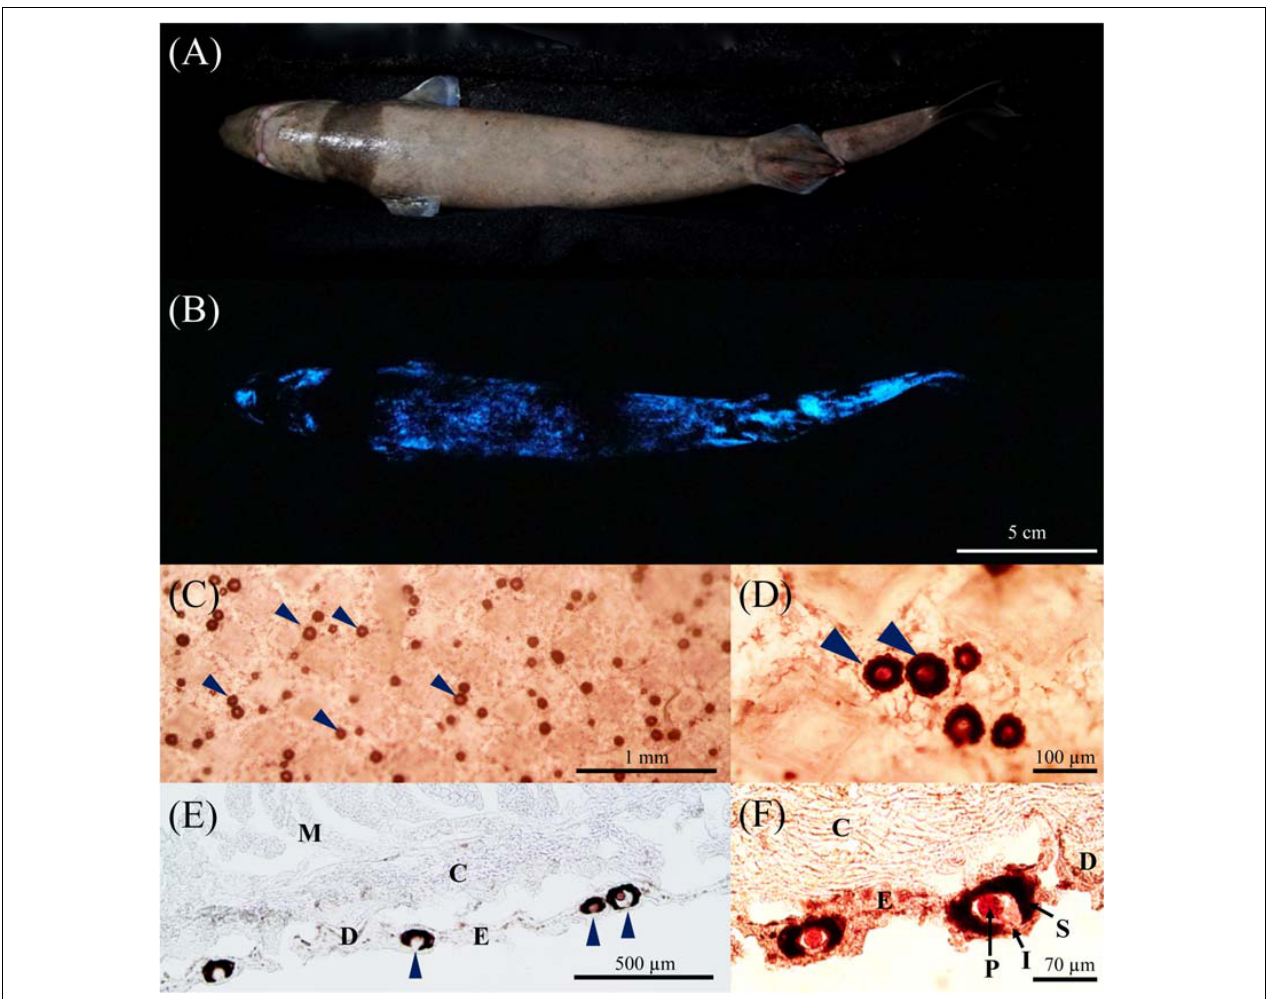
FIGURE 1 | Bioluminescence of Isistius brasiliensis . (A) Ventral side of I. brasiliensis. The dark-collar or black band is visible on the anterior part. (B) The ventral luminous pattern observed on the ventral side. An absence of bioluminescence is observed on the dark collar. The dark region in the middle of the shark is artifactual and corresponds to the area where the specimen was stabilized for the picture. (C,D) In vivo observation of the photophores present on the ventral skin region. (E,F) Observation of the photophores using classical histology. Arrows indicate the epidermal photophores. Legend, C, connective tissue; D, dermal denticle; E, epidermis; M, muscles; I, iris-like structure; P, photocyte; S, pigmented